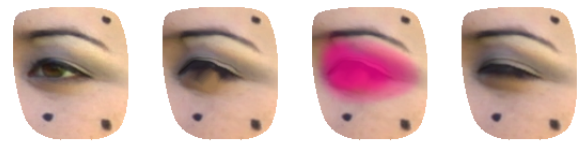
Influence brush. Left to right: the reference region, an erroneous result, application of the influence brush to weaken the influence of the image data, and the corrected